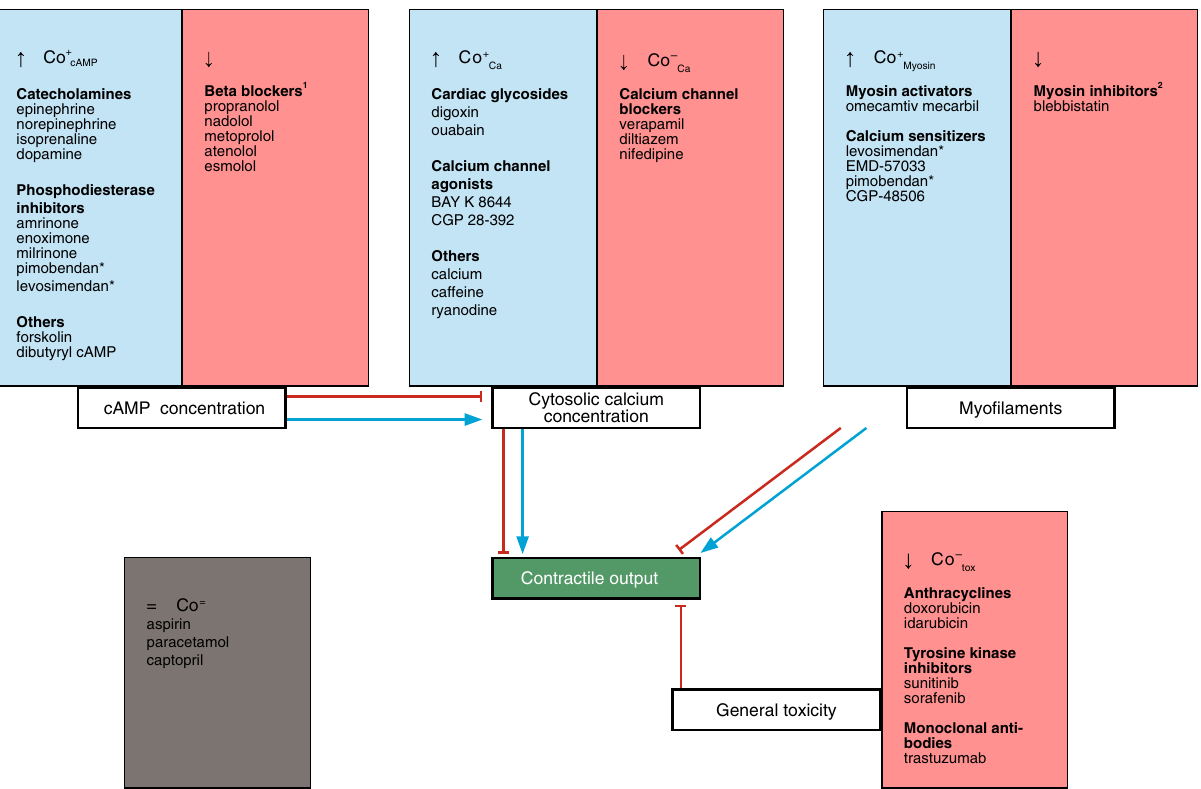
Fig. 1 Schematic of critical mechanisms affecting cardiomyocyte contraction targeted by drugs. Most therapeutics that target the heart or have off-target effects on the heart fall within the mechanisms shown. 1: Since no beta-adrenergic agonists are present in in vitro cultures with de fi ned medium, this category is not relevant in this study. 2: This group is small and the mechanisms are not speci fi c. For example, while blebbistatin reduces contractility, it also affects cardiomyocyte electrophysiology. Therefore, this category is not included in this study. Asterisk: These compounds exhibit both PDE inhibiting and myo fi lament Ca 2 + sensitizing properties, with the dominant mechanism typically depending on the concentration